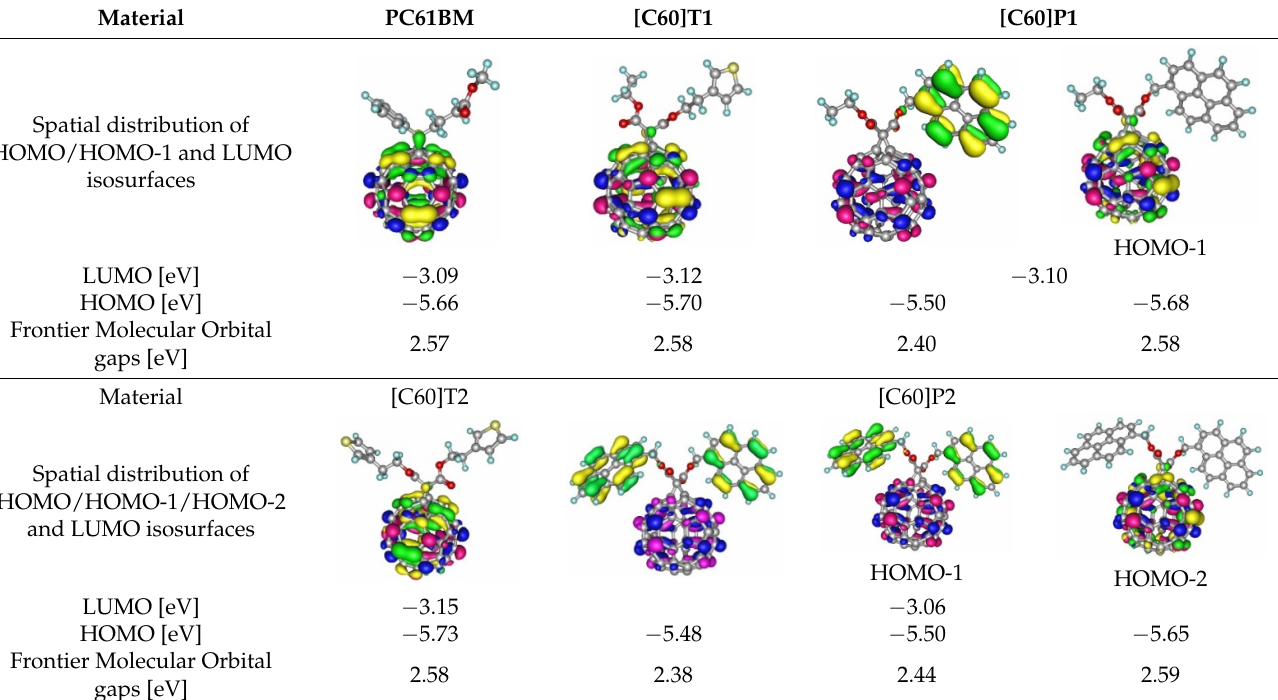
Table 1. HOMO (also HOMO-1 and HOMO-2 for selected compounds) and LUMO energies of the optimized fullerene derivatives obtained by DFT calculations. Additionally, spatial models of corresponding HOMO and LUMO with yellow and purple lobes corresponding to positive, and green and blue lobes to negative isosurface